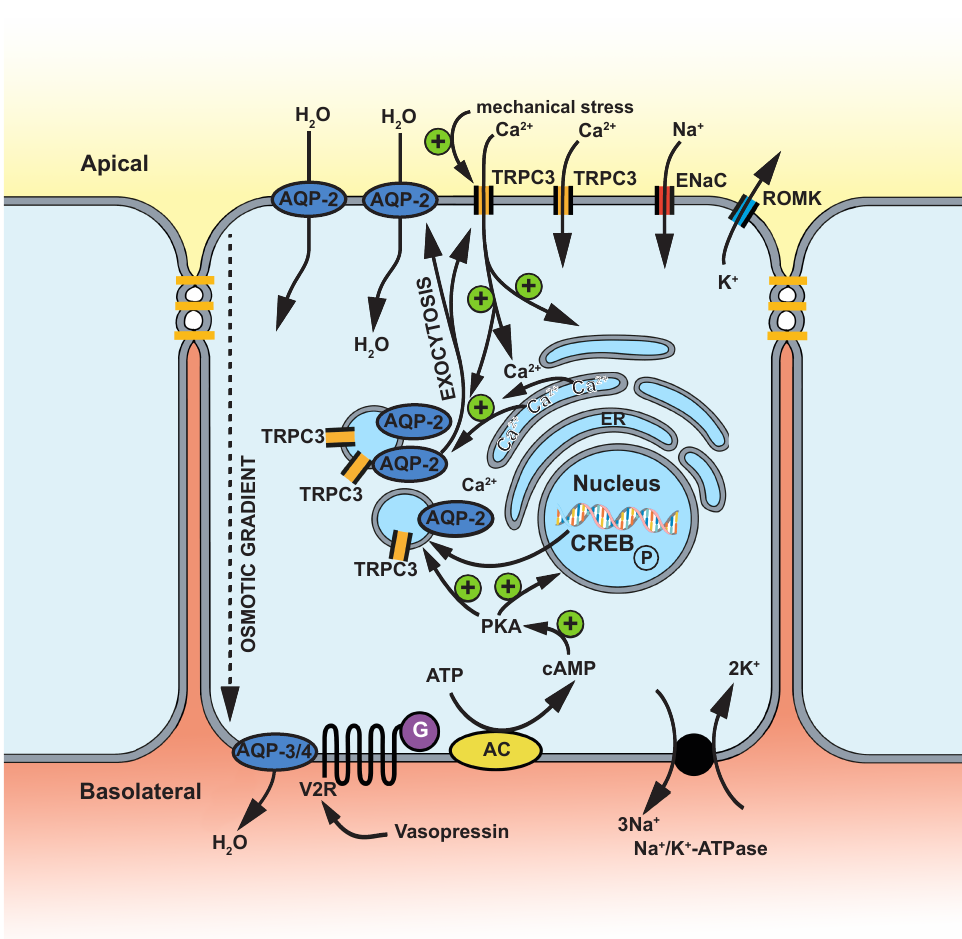
Figure 4. The postulated function of TRPC3 in the collecting duct. Arginine vasopressin stimulates the V2 vasopressin receptor (V2R). A signaling pathway is triggered leading to the generation of cyclic adenosine monophosphate (cAMP) and the activation of the protein kinase A (PKA). Membrane trafficking of aquaporin-2 (AQP-2) and TRPC3, as well as antidiuretic gene expression, is enhanced (CREB or cAMP response element-binding protein). TRPC3 is involved in Ca 2+ reabsorption and sensing of hypotonicity by initiating Ca 2+ signaling with direct and indirect stimulation of AQP- 2 membrane trafficking. AQP-2 and AQP-3/4 mediate, respectively, apical and basolateral H 2 O flow along the osmotic gradient. The epithelial Na + channel (ENaC) and renal outer medullary K + channels (ROMK) mediate apical Na + influx and K +